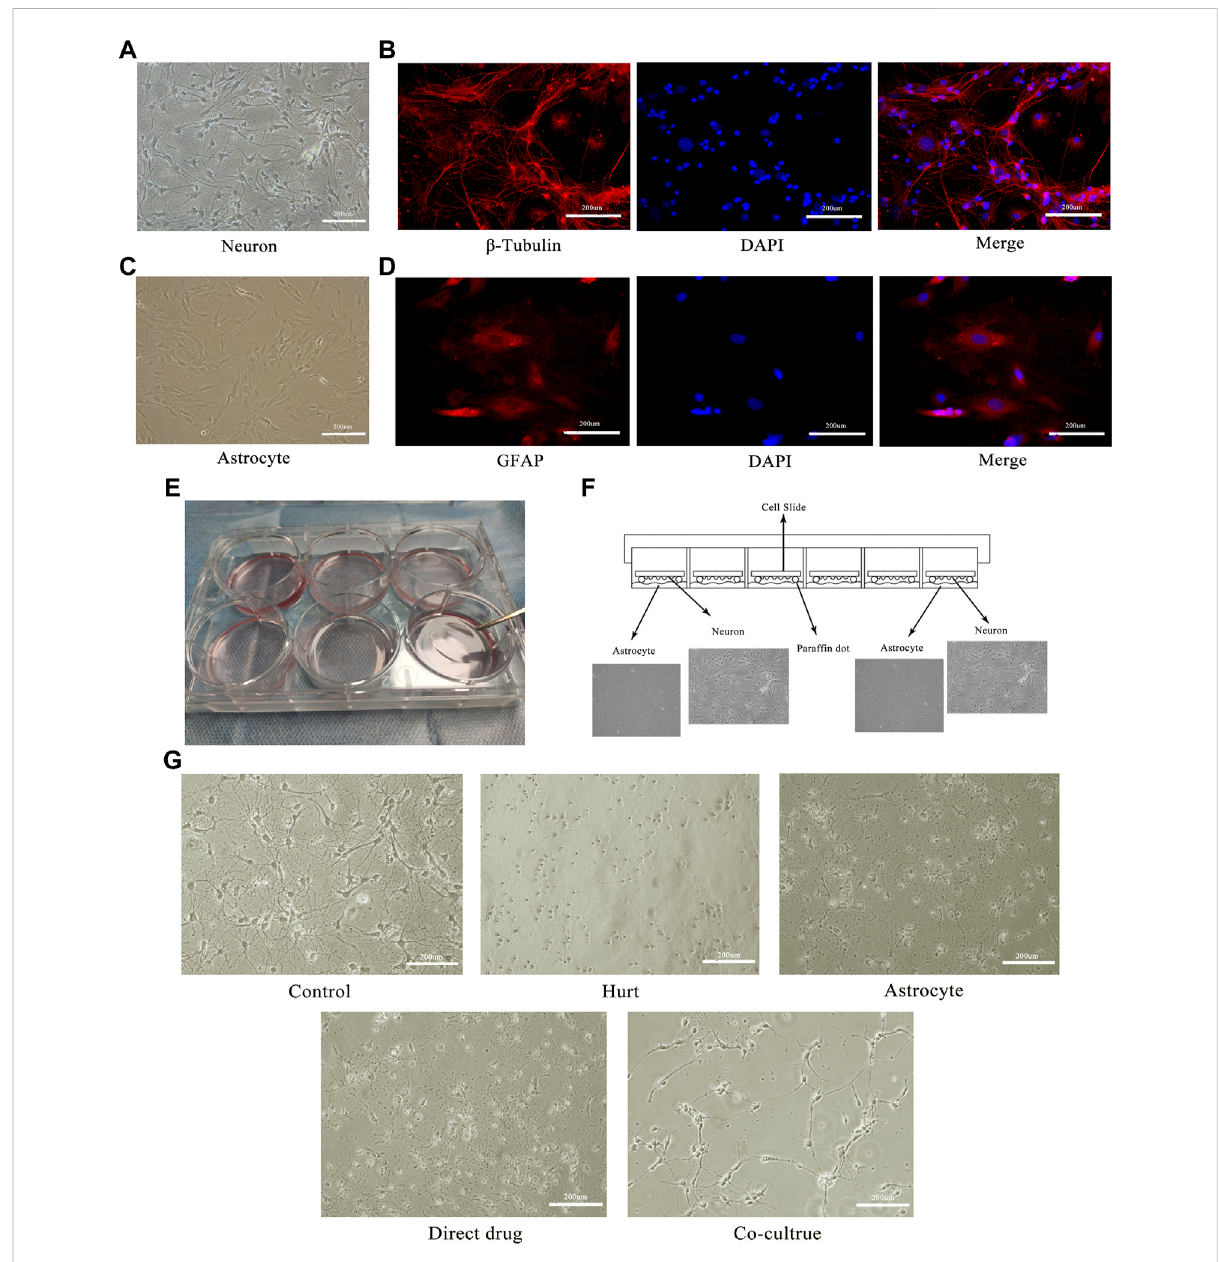
FIGURE 8 TFHL promotesmorphologicalrepair ofinjured SMNs. (A) Themorphology ofthemotor neurons intheanteriorhorn of thespinal cord undera 20× optical microscope. (B) The immuno fl uorescence identi fi cation of spinal motor neurons with speci fi c antibodies of β -Tubulin. (C) The morphologyofastrocytesinthespinalcordundera20×opticalmicroscope. (D) Theimmuno fl uorescenceidenti fi cationofspinalcordastrocytesby GFAP speci fi c antibody. (E,F) The physical image and schematic diagram of the cell co-culture model. (G) The changes of injured spinal motor neurons in each group after treatment with TFHL under a 20× optical microscope.